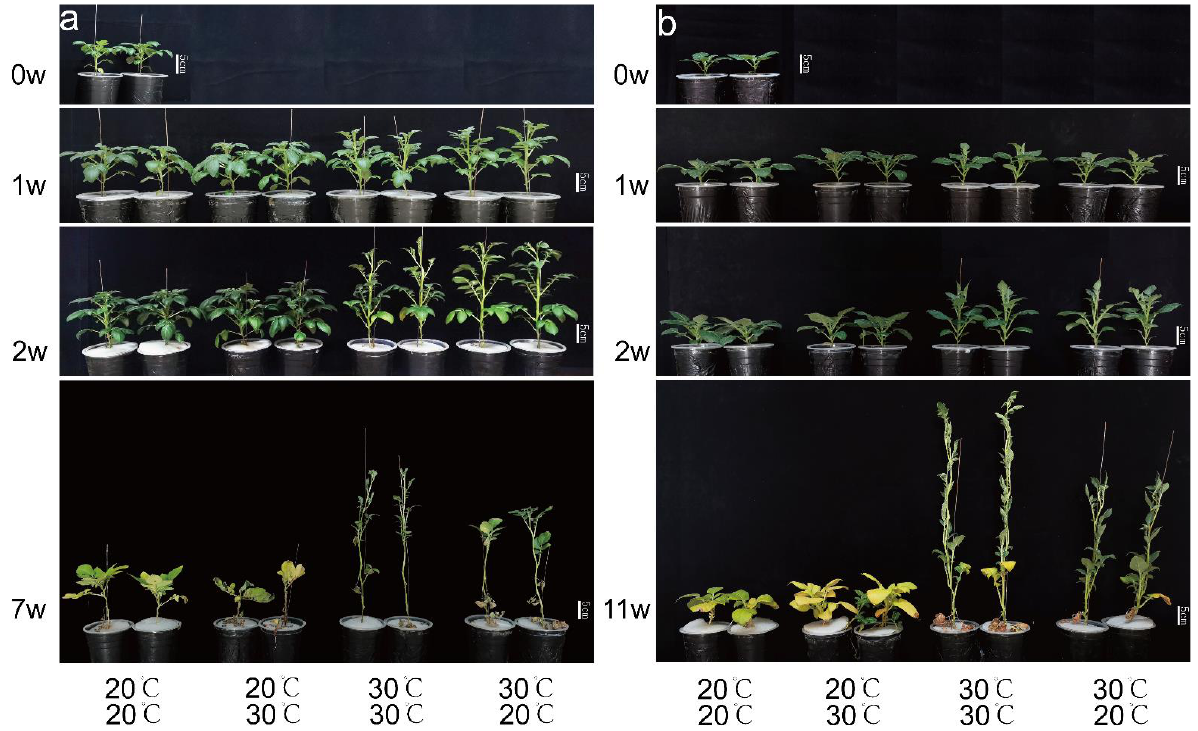
Figure 2. Phenotypes of the aerial plant parts of Qs9 ( a ) and D187 ( b ) under the heat-stress treatment of different plant parts. Potato plants were grown for 0, 1, 2, 7, or 11 weeks at the indicated temperature. Representative pictures among 9 replicates are displayed. w, weeks.